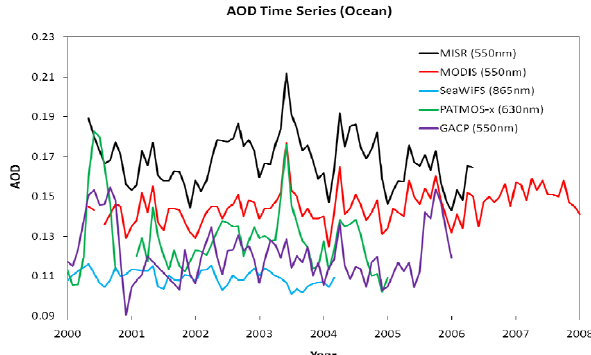
Figure 1. Comparison of global mean AOD over ocean derived from different satellite input data and retrieval algorithms for an overlapping period since 2000. Different retrieval algorithms assuming different aerosol models (some even retrieve aerosol model such as MODIS algorithm). Converting AOD from retrieval channels to the standard 550nm wavelength depend on the aerosol model used or retrieved and the extrapolation may introducing extra errors, especially for the algorithm using fixed aerosol model (such as AVHRR). Thus, we decide to display the AOD in the retrieval channel instead of extrapolating to the standard wavelength 550nm.